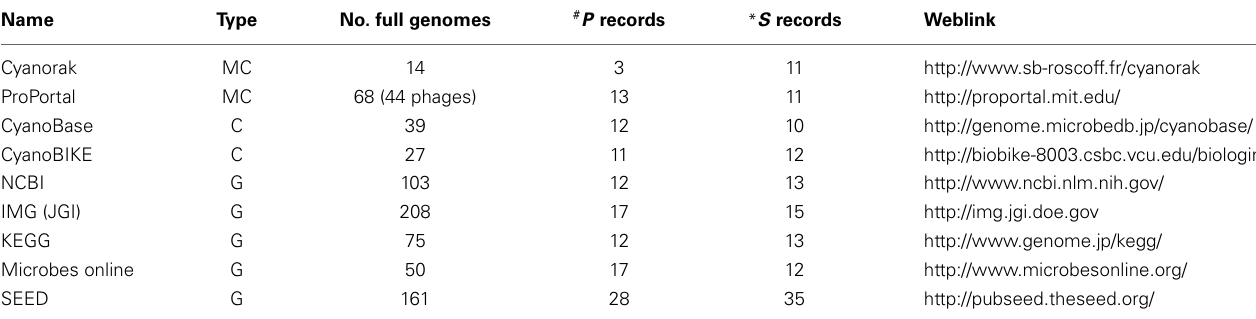
FIGURE 2 | World map showing genomic records for cyanobacteria generated using an interface powered by google maps, available on the Genomes Online Database (GOLD) website (http://genomesonline. org/cgi-bin/GOLD/index.cgi). Red labels indicate the original location of a specifically sequenced strain. Labels direct the user to information on the Table 1 | Publically available full genome sequences for cyanobacteria in various repositories as at April